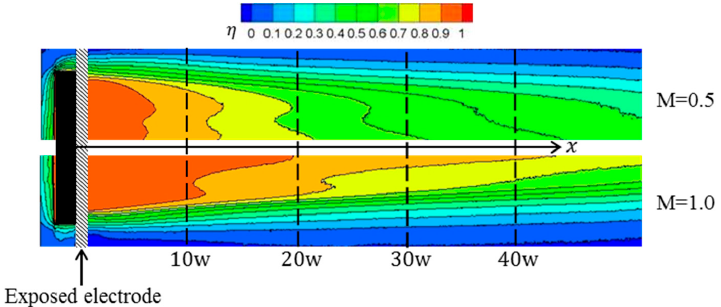
Figure 4. Distribution of film cooling effectiveness without plasma.